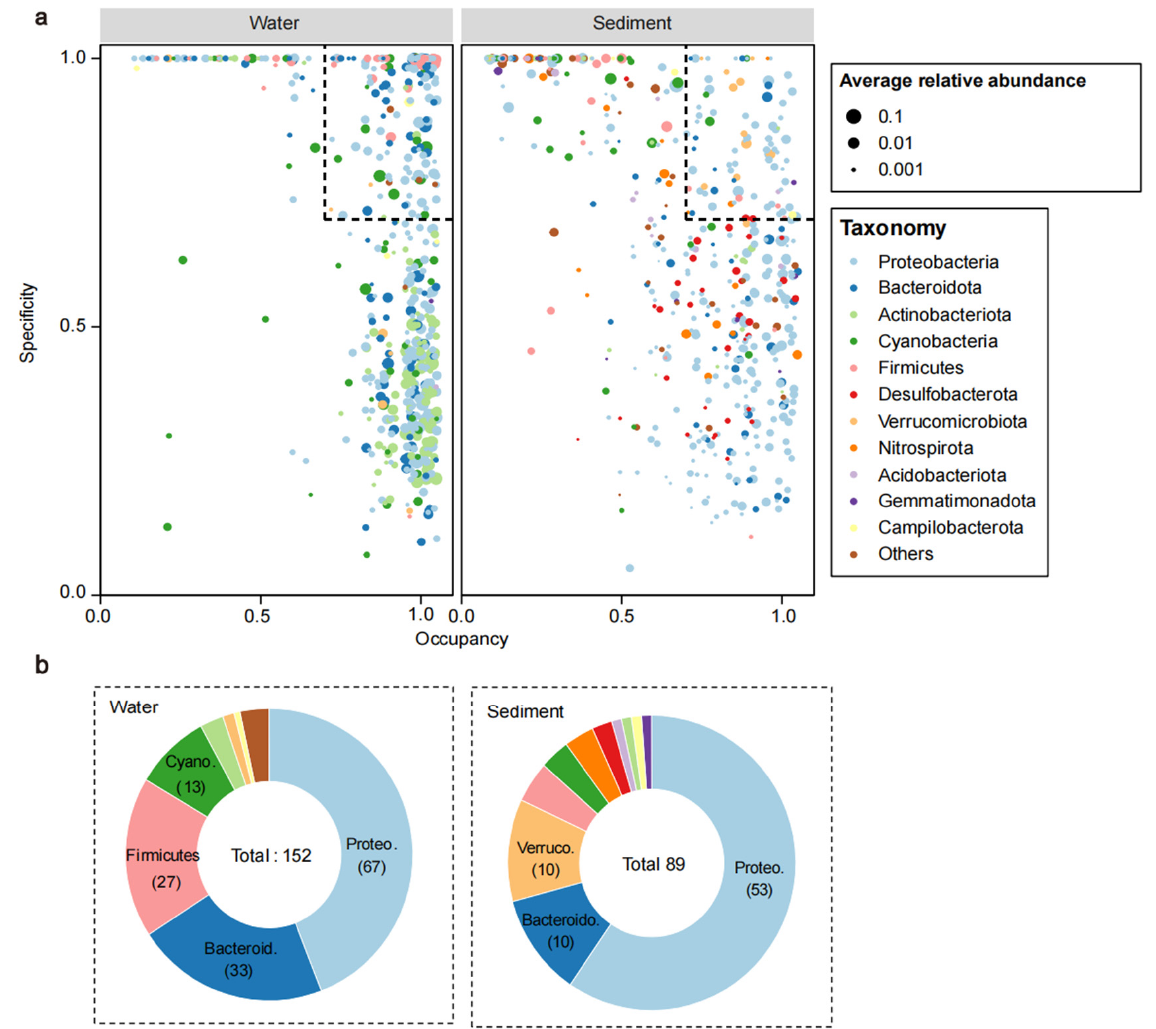
Figure 4. The SPEC-OCCU plots ( a ) show 500 most abundant ASVs in each habitat, the x-axis indicates the occupancy rate of ASVs in all sample sites, the y-axis indicates the specificity of ASVs in the habitat. The dotted box shows the specialized species (specificity and occupancy greater or equal to 0.7). Pie charts ( b ) show the number of ASVs representing specialists in each habitat. The NMDS based on the Bray-Curtis distance was used to evaluate the bacterial community composition. The result in Figure 5a show that the community of bacterioplankton have a prominent seasonal group (Global R = 0.661, p = 0.001). In contrast, the seasonal groups were not evident in the sediment bacterial community for bacterioplankton (Global R = 0.423, p = 0.001, Figure 5b). Furthermore, bacterial community composition was extremely different in the two habitats (Global R = 0.898, p = 0.001, Figure 5c).